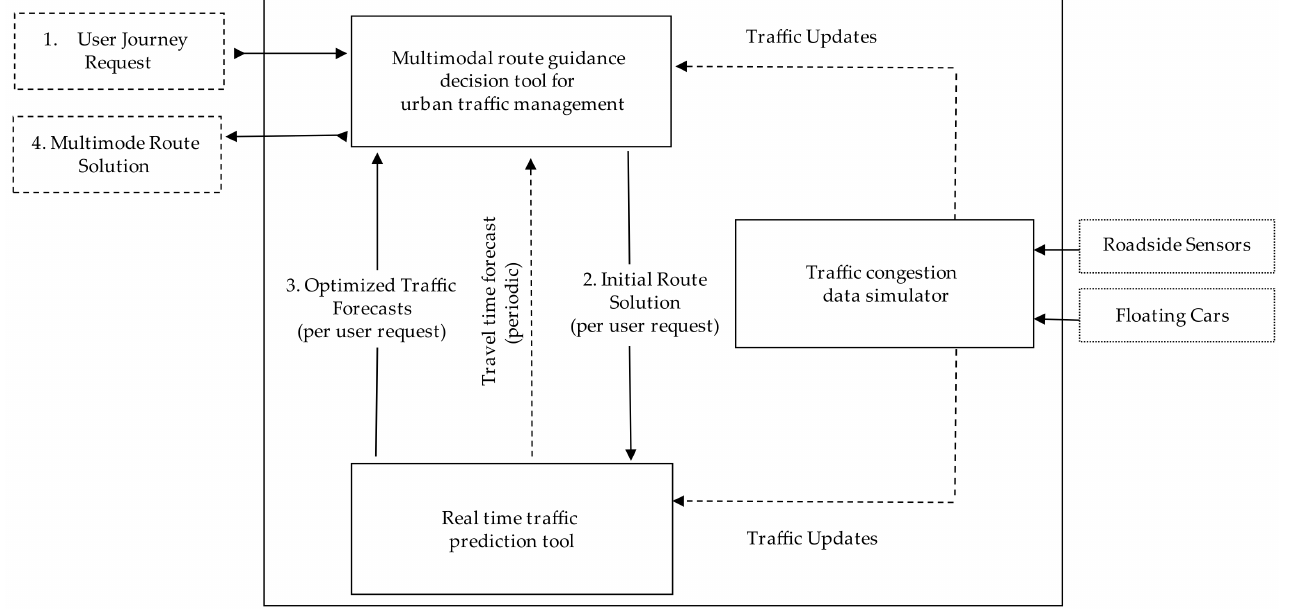
Figure 1. Overview of the complete intelligent multimodal transportation